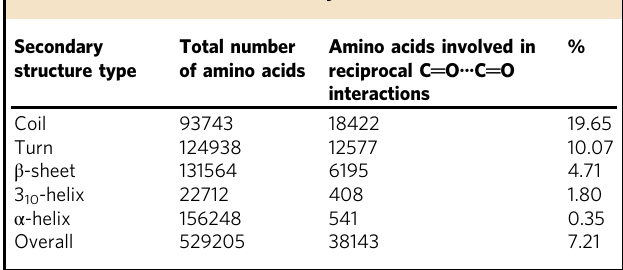
Table 4 Distribution of reciprocal carbonyl-carbonyl interactions in various secondary